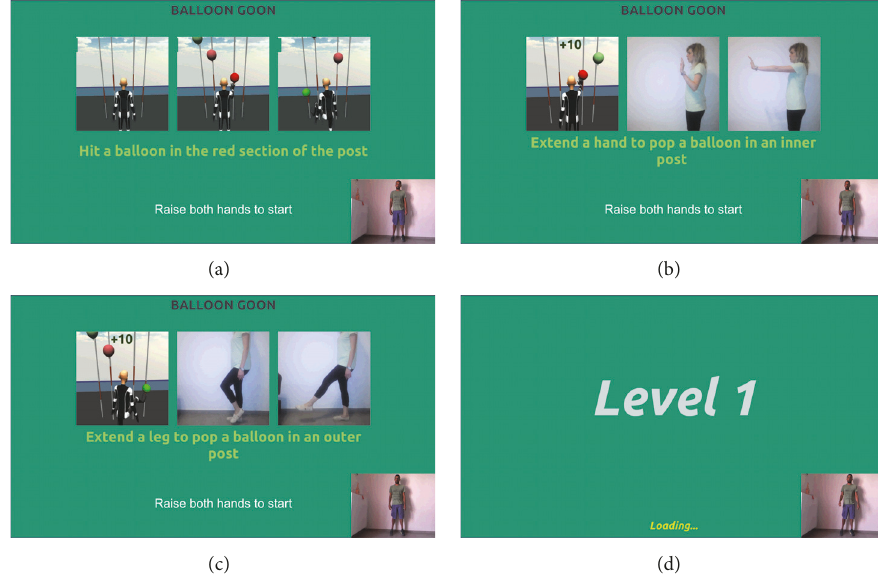
Figure 3: Successful recognition of the gesture shown in Figure 2(a) selects and activates the Balloon Goon game. The game starts by displaying three screens (a through c in the current figure) stating the objective of the game and easy to follow instructions on how to pop balloons by “punch” or “kick.” Finally, d shows that the first level for this game is being loaded.